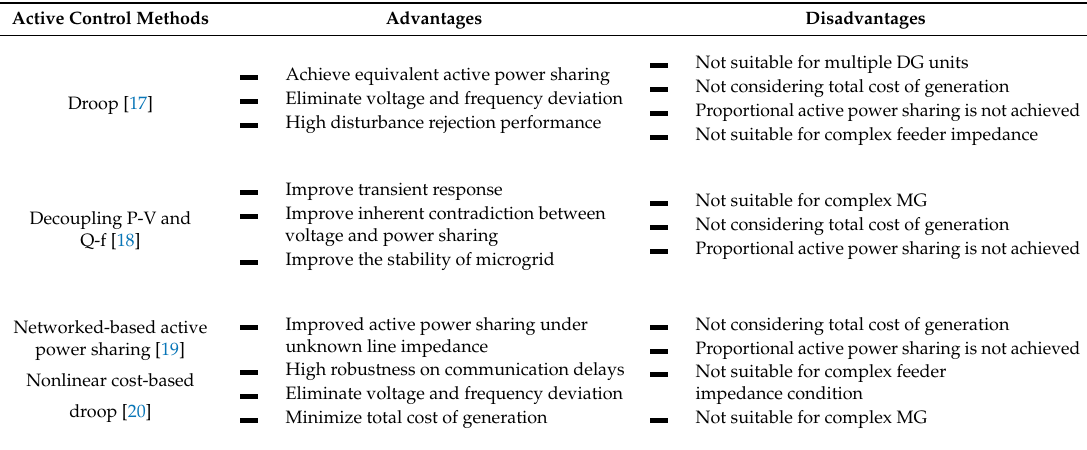
Table 1. Active power sharing techniques and